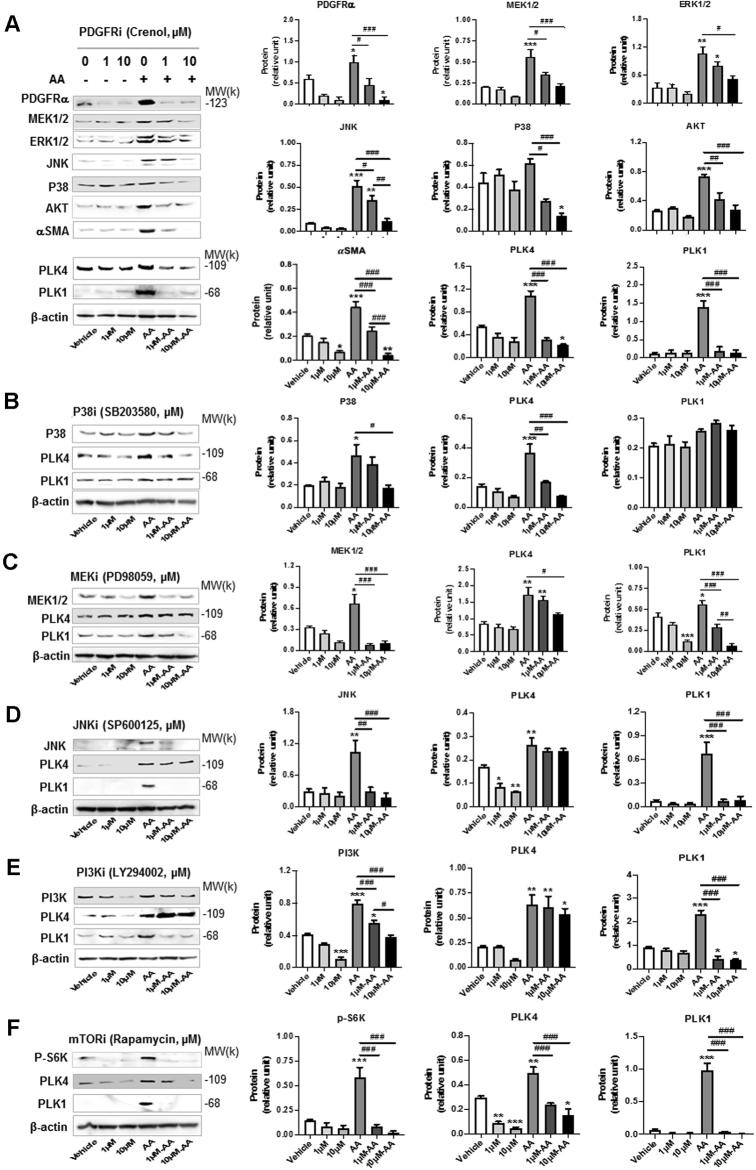
Long-Term Regulation of PLK4 Protein LevelsRat adventitial fibroblast cells were cultured and starved as described in Figure 1. Cells were pretreated for 30 min with vehicle or an inhibitor for (A) PDGFR, (B) P38, (C) MEK/ERK, (D) JNK, (E) PI3K, or (F) mTOR at indicated concentrations and stimulated for 24 h with AA (60 ng/ml) before harvest for Western blot analysis. Quantification: mean ± SEM, n ≥3 experiments, 1-way ANOVA/Bonferroni test: #p < 0.05; ##p < 0.01; ###p < 0.001. ∗p < 0.05; ∗∗p < 0.01; ∗∗∗p < 0.001 compared with the basal control (vehicle without AA, the first bar in each plot). Abbreviations as in Figures 1 and 4.